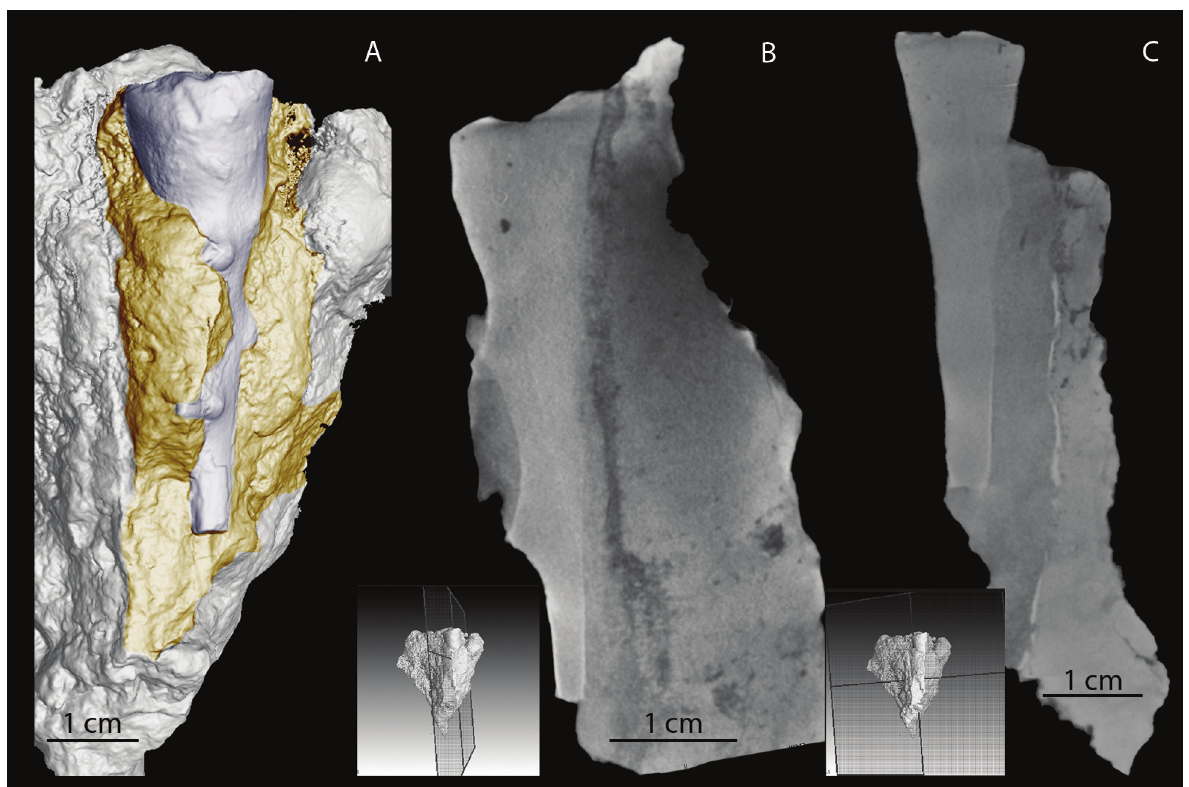
Fig. 7. Tomograms of Martsaphyton moxi gen. et sp. nov. A , front view of the specimen, with colour adjustment highlighting the skeleton and the adjacent surrounding yellow matrix; B , C , virtual longitudinal sections through the specimen demonstrating differential preservation of the back side of the skeleton: ambiguous boundary between the skeleton and the matrix due to dissolution (B), and normal preservation of the skeleton wall